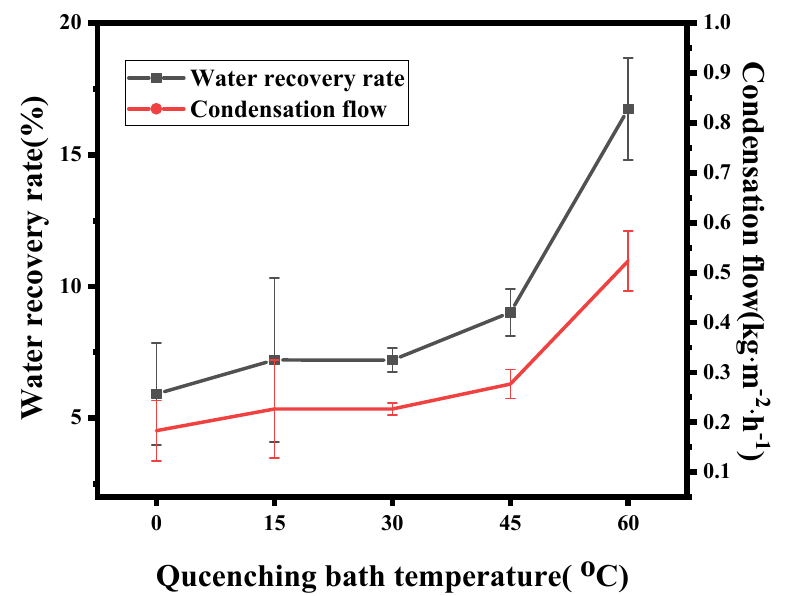
Figure 13. MC performance of ECTFE membranes prepared at different cooling rates.